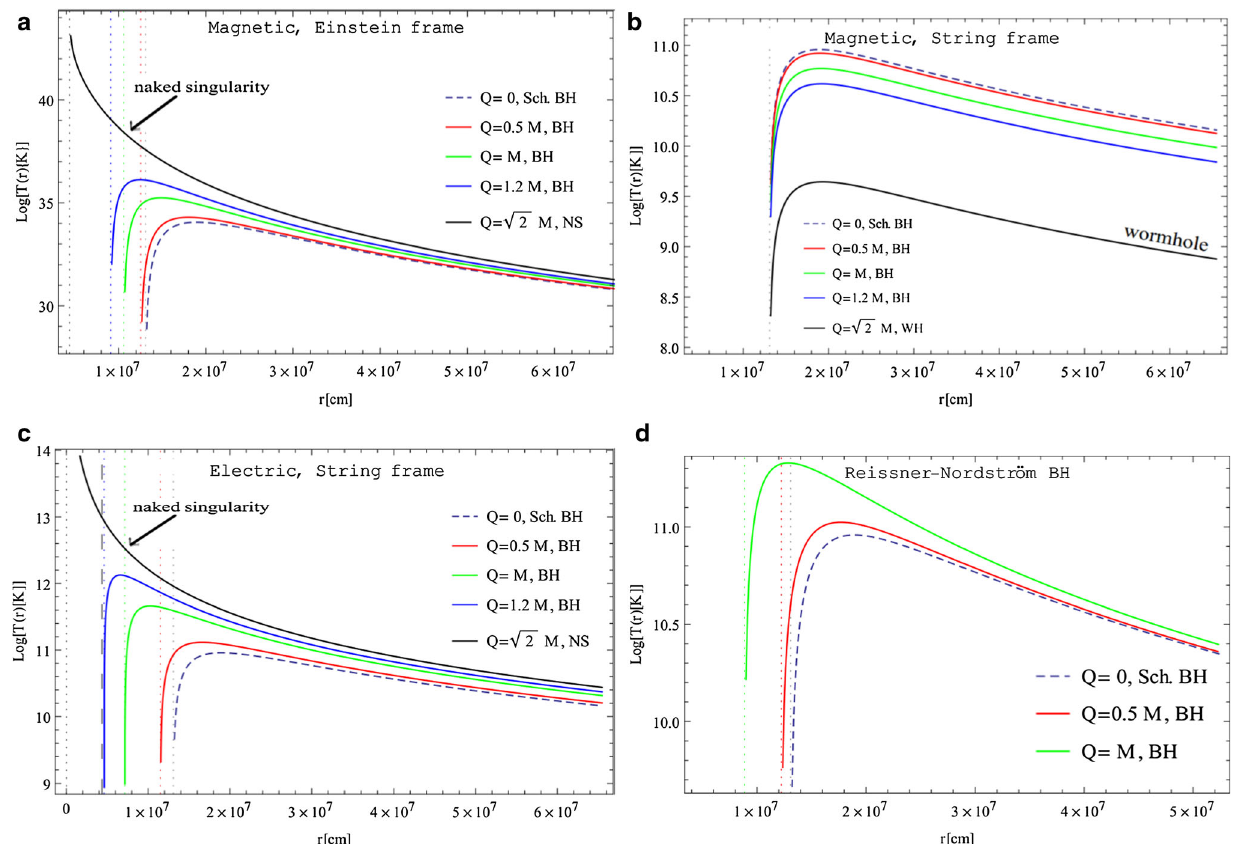
Fig. 5 Temperature distribution T ( r ) of of the accretion disk for a GMGHS BH in EF ( a ), magnetically charged in the SF ( b ), electrically charged in the SF ( c ) and Reissner–Nordström BH ( d ) plotted for dif- ferent values of Q . We see that T ( r ) → ∞ at NS radii 2 M coinciding